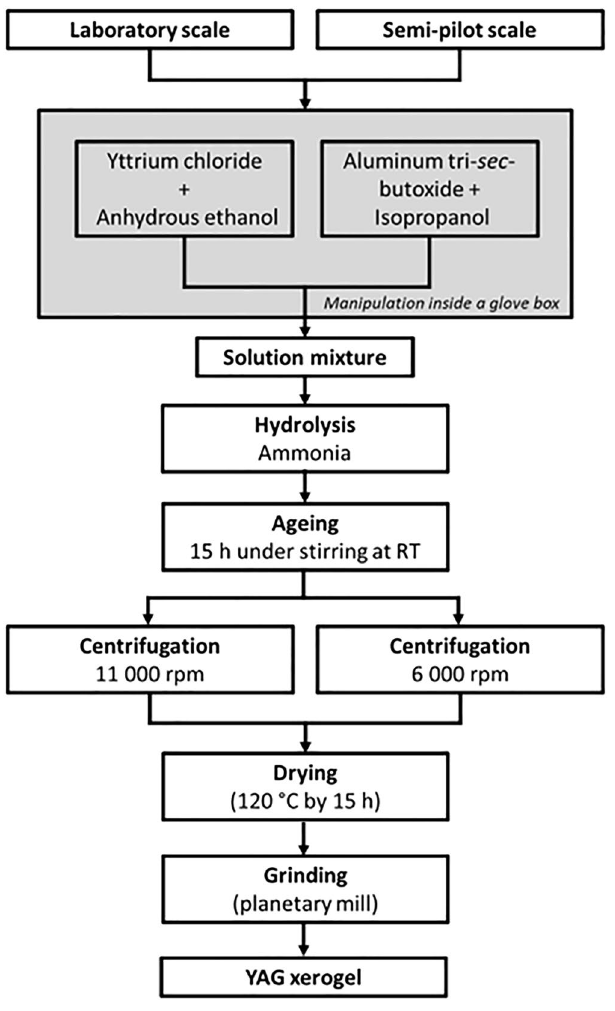
Figure 1. Preparation protocol for L and SP